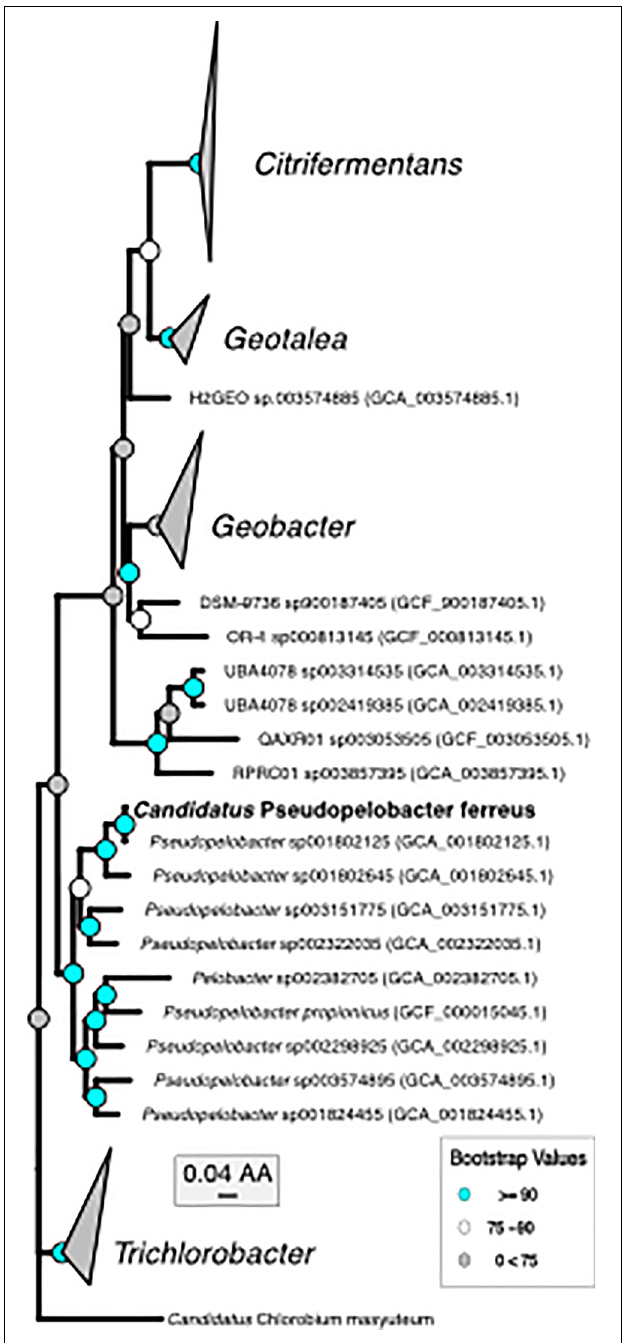
FIGURE 2 | Phylogenomic tree of “ Ca. P. ferreus” with the only other isolated organism in the genus and metagenome-assembled genomes of closely related